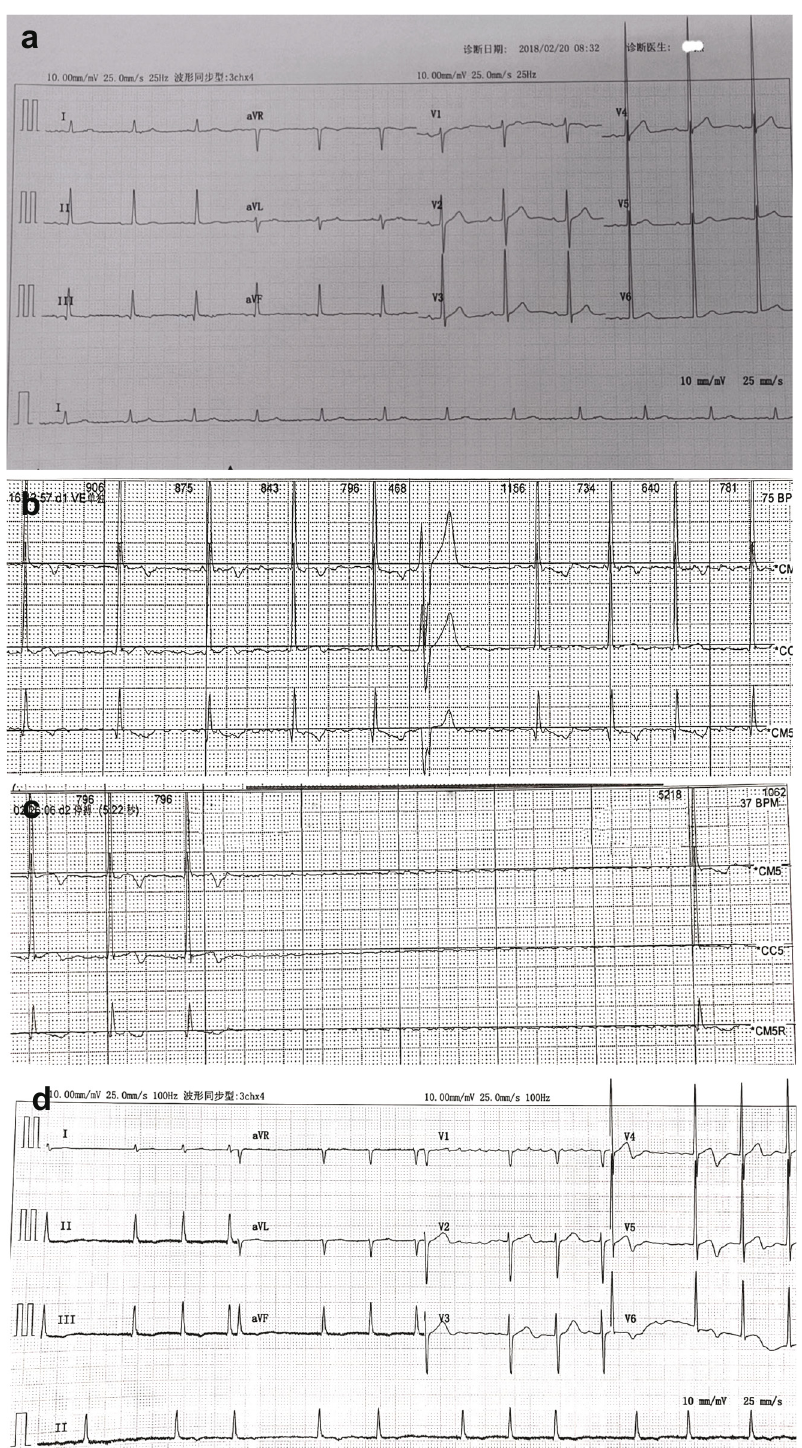
Figure 2: ECG of patient during treatment. ( a ) Normal ECG before atrial fi brillation and RR interval prolongation; ( b ) the fi rst holt result showing atrial fi brillation occurring during thalidomide treatment; ( c ) the fi rst holt result showing serious RR interval prolongation ( RR interval = 5.2 s ) during thalidomide treatment; and ( d ) atrial fi brillation did not disappear after after four cycles of treatment. The RR interval gradually indicating that RR interval prolongation was induced by returned to normal range after discontinuation, thalidomide. However, atrial fi brillation did not disappear